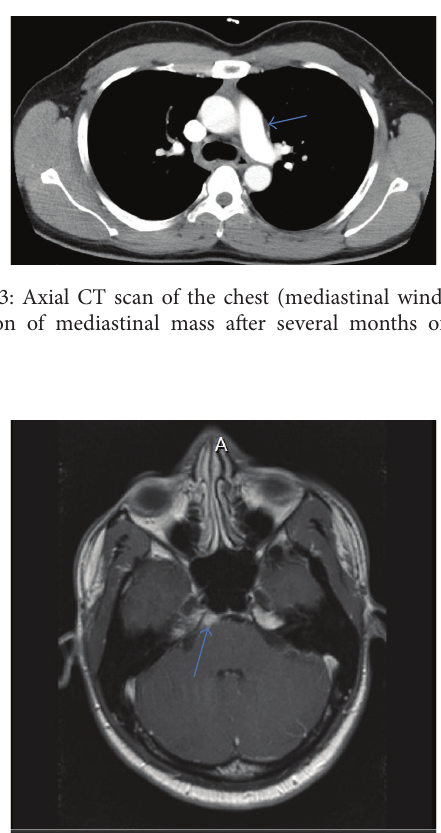
Figure 4: MRI of brain T1 axial + gadolinium showing small tuber- culoma in the right prepontine cistern before anti-TB